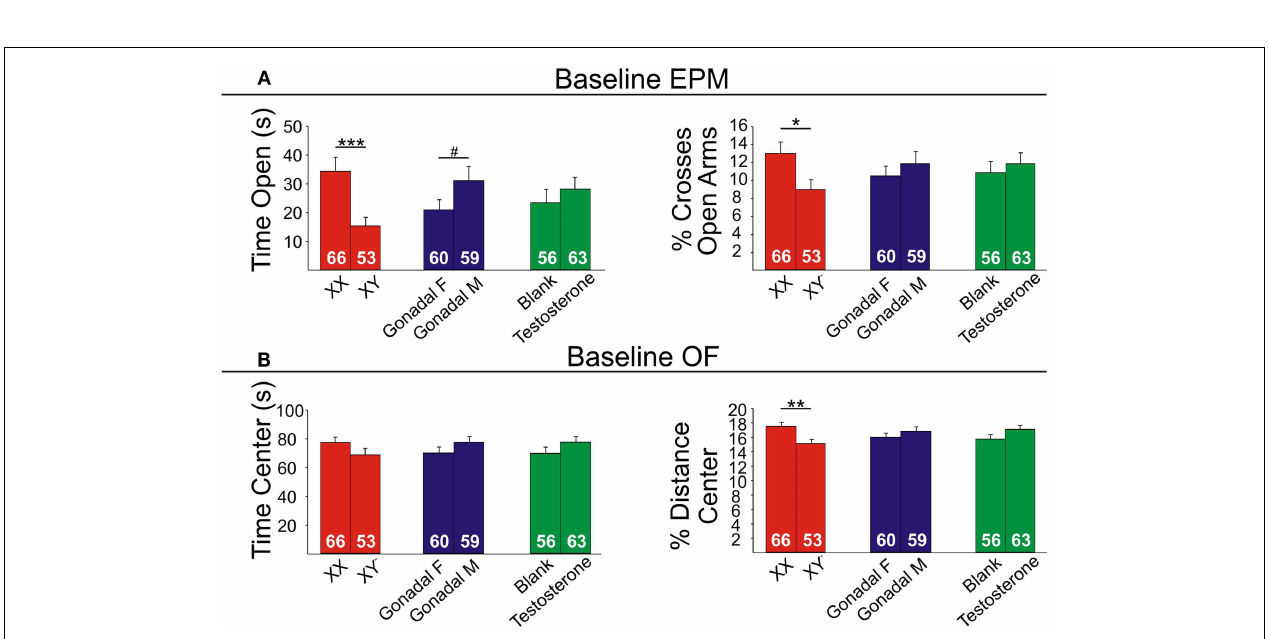
distance (right) in the center. Numbers at the base of bars indicate group sizes. Error bars indicated mean ± SEM. *** p < 0.001, ** p < 0.01; * p < 0.05; # p <